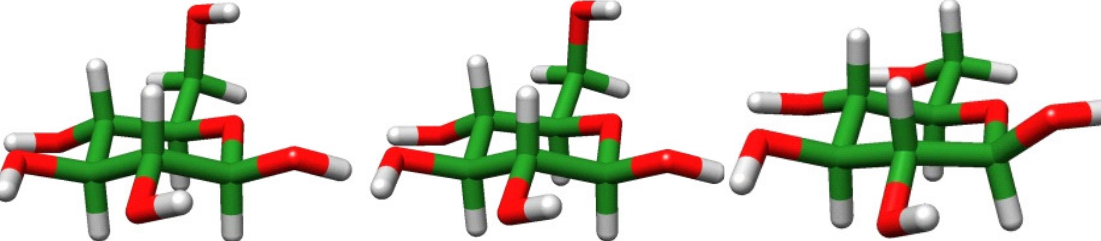
Figure 4. From left to right: the most stable structures obtained by DFT calculation, MM calculations using our proposed force field framework, and using the GLYCAM06 force field framework,